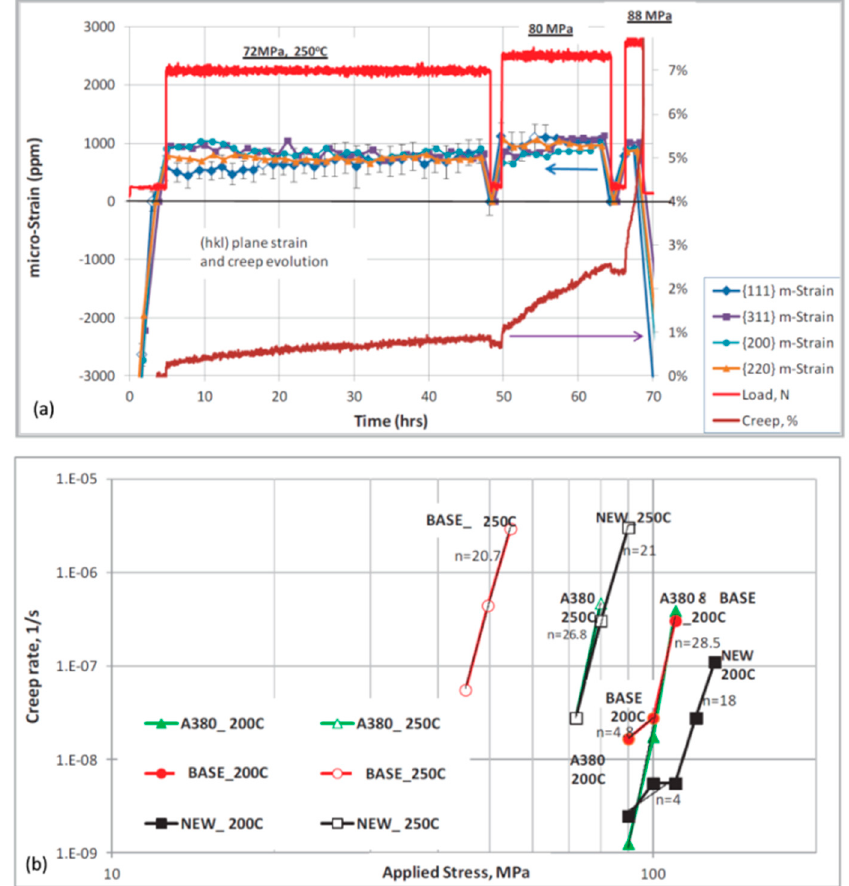
Figure 13. Application of neutron diffraction to the in situ study of thermal stability through measurements of creep evolution: ( a ) creep strain (%) and elastic microstrain (ppm) evolution at selected hkl planes at 250 °C under ascending cyclic loading for Al alloy marked as New below; ( b ) calculated stress exponents of the tested alloys at 200 °C and 250 °C. Alloys: A380: Al9.5Si − 3.4Cu, Base: Al − 7.1Si − 1Cu − 0.5Mg, New: Al − 7Si − 0.9Cu − 0.5Mg − 0.56Zr − 0.20Ti − 0.32V (wt.%) [50].